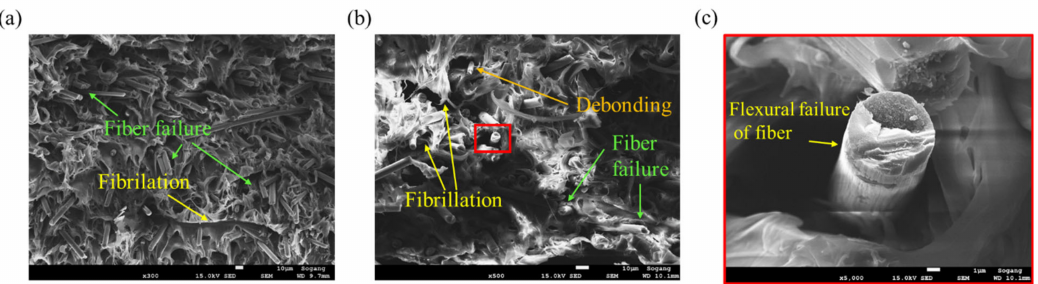
Figure 14. Fracture mechanism observed for θ = 0 ◦ compressive specimen, ( a ) fiber failure and fibrillation (magnification: × 300, scale: 10 µ m), ( b ) fiber-matrix debonding (magnification: × 500, scale: 10 µ m), ( c ) fracture face of the fiber after flexural failure (magnification: × 5000, scale: 1 µ m).